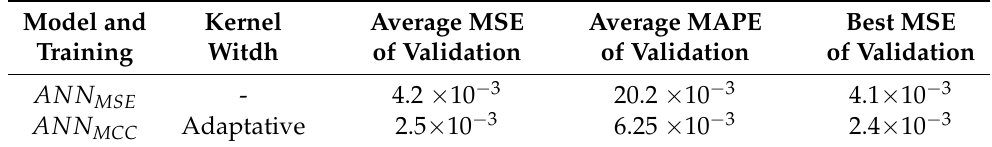
Table 5. Performance comparison of ANN models. State of Charge—training result with the presence of noise or outliers—Constant Current Discharge.